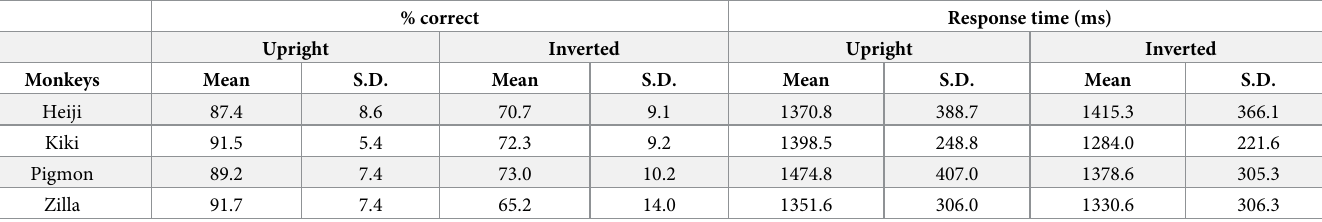
Table 1. Mean percentages of correct responses and mean response time data in eight pretest sessions for each stimulus orientation condition and each